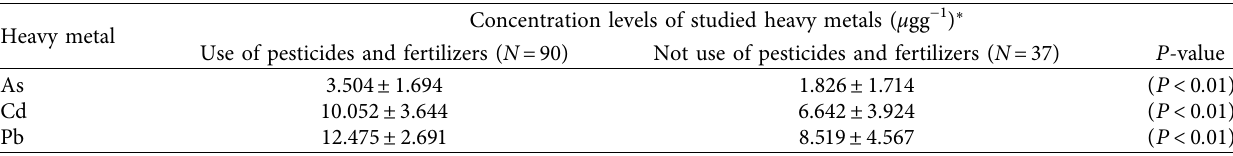
Table 7: Concentration of As, Cd, and Pb in fingernails of the participating farmers according to pesticides and fertilizers usage. Heavy metal